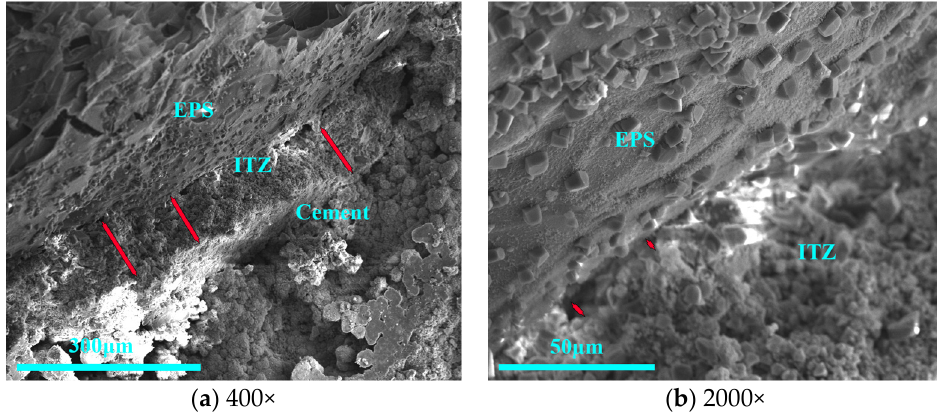
Figure 7. Microstructure of interface treated with sodium silicate.